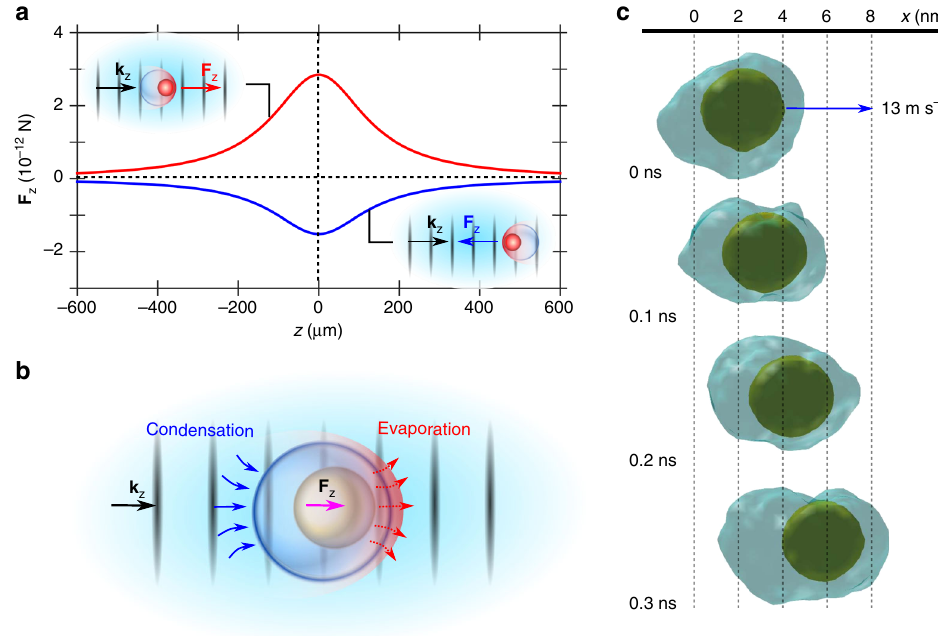
Fig. 3 Positive and negative optical forces and the nanoscale Leidenfrost effect. a The calculated F z on an Au NP with a nanobubble along the central axis ( z -direction) of the Gaussian beam. A beam waist and intensity at the focal plane ( z = 0) are 6 μ m and 12 mW μ m − 2 , respectively. The red line represents the positive force for r nb = 130 nm, θ = 180 o , and the blue line represents the negative force r nb = 130 nm, θ = 0 o . The insets illustrate (left top) the positive motion and (right bottom) the negative motion. b Schematic illustration of a supercavitating ballistic Au NP. Under the laser illumination, the plasmonic Au NP is intensely heated to generate a nanobubble which encapsulates it. When the Au NP moves forward, it keeps evaporating water and maintaining a vapor cushion in front of it, which effectively makes the NP moving in a virtually frictionless environment, like the Leidenfrost effect. In the meantime, vapor at the trailing end of the bubble cools and condenses back to liquid as the hot NP moves forward. c Nanoscale Leidenfrost effect of a hot moving NP simulated by molecular dynamic (MD) simulations. The hot NP is thermostated at 1000K (Supplementary Note 9 for justi fi cation), and the blue contour visualizes the isosurface of the critical density of liquid argon (0.536 g cm − 3 ), which represents the nanobubble surface. The NP moves in the positive x -direction with a speed of 13 m s − 1